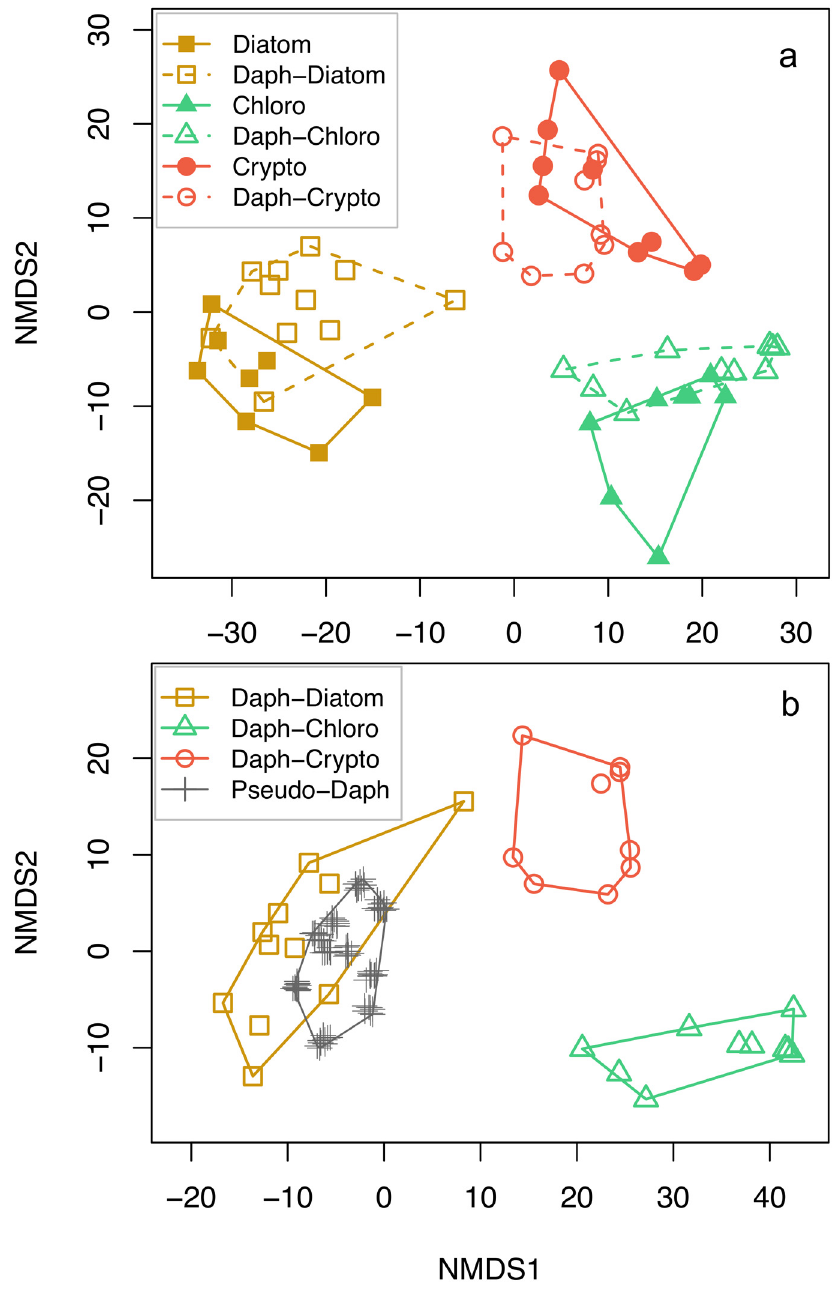
Fig 1. Non-metric multi-dimensional scaling (NMDS) plots of the FA profiles used (n = 26 FA; Euclidean distance). One outlier cryptophyte profile is removed from the NMDS plots for clarity, but this outlier was included in the FA-based analyses. A) Algal diets (filled symbols) and Daphnia fed those diets (open symbols) and associated resource polygons for each treatment group (stress = 0.09). B) The real Daphnia in the ‘ consumer-resource library ’ (no algal diets), with 100 ‘ pseudo- Daphnia ’ used in the analyses (see Methods; stress =